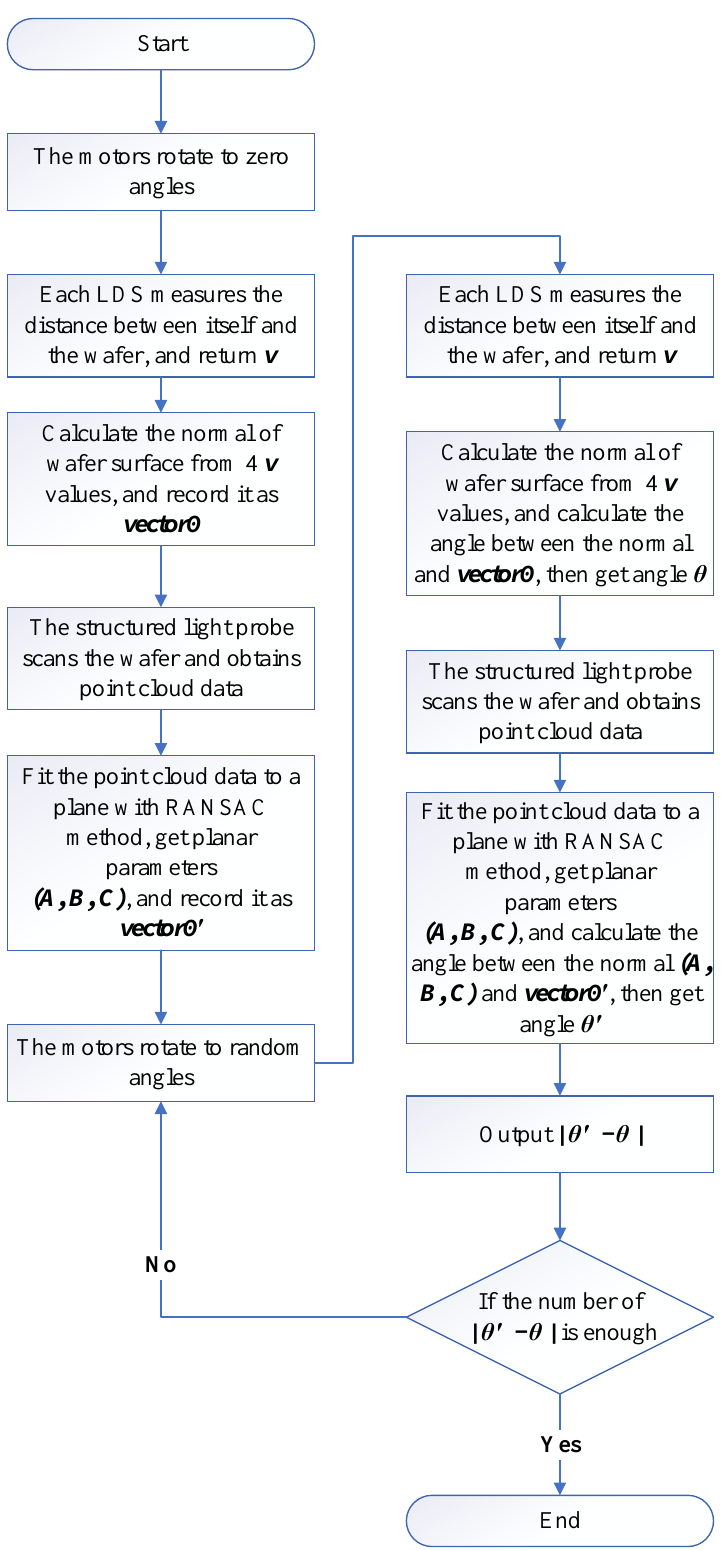
Figure 17. The validation procedure of the